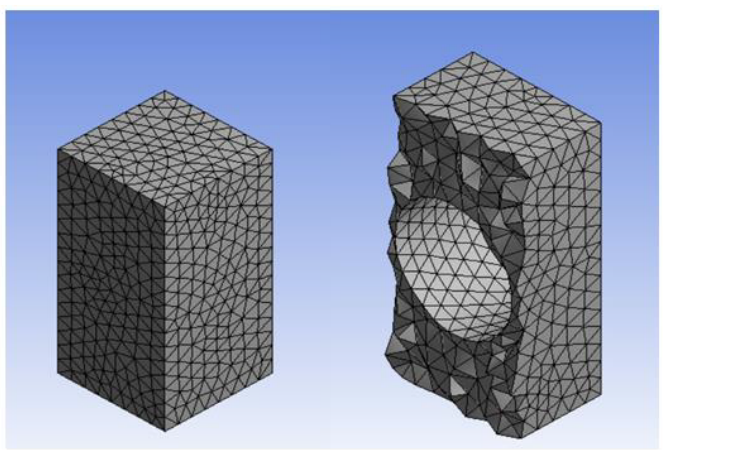
Figure 6: Mesh at the stationary domain.